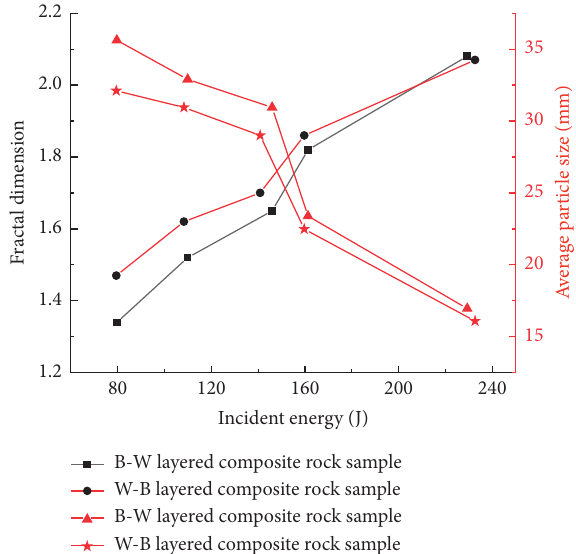
Figure 11: Relationship between the fractal dimension and average particle size with incident